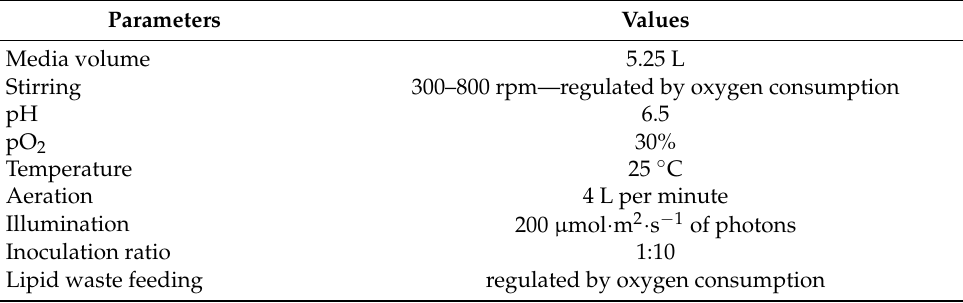
Table 2. Bioreactor process values during